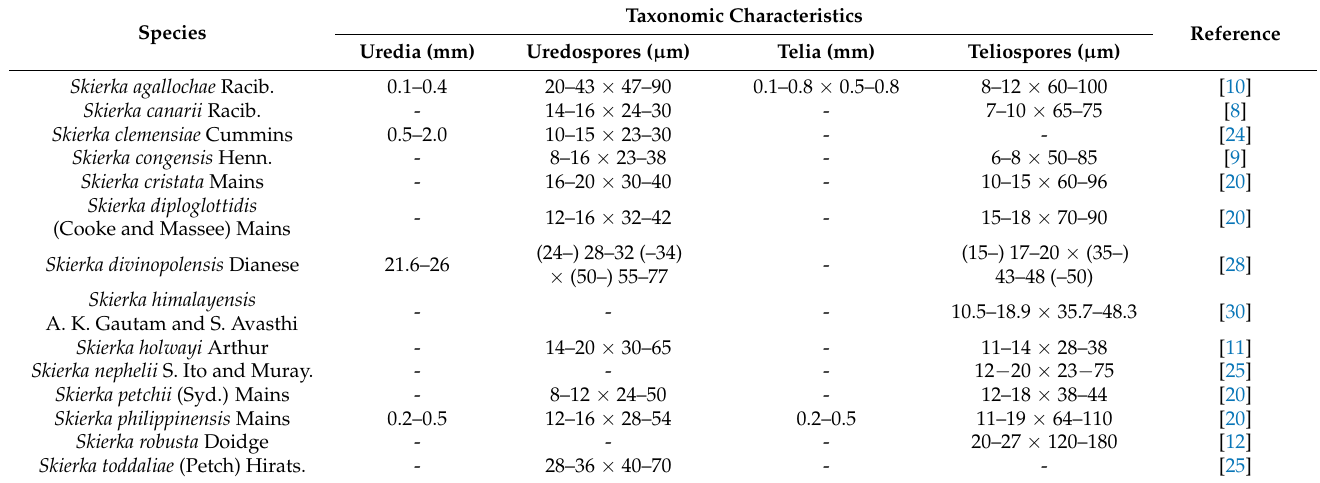
Table 4. A comparative account of the morphological characteristics of Skierka